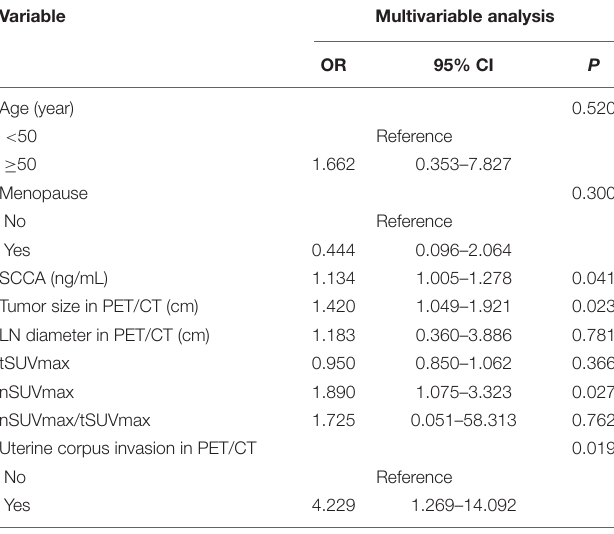
TABLE 2 | The variables identified by logistic multivariable regression